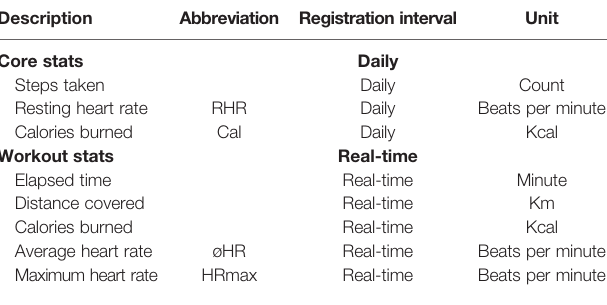
TABLE 3 | Measurements with the fi tness tracker.